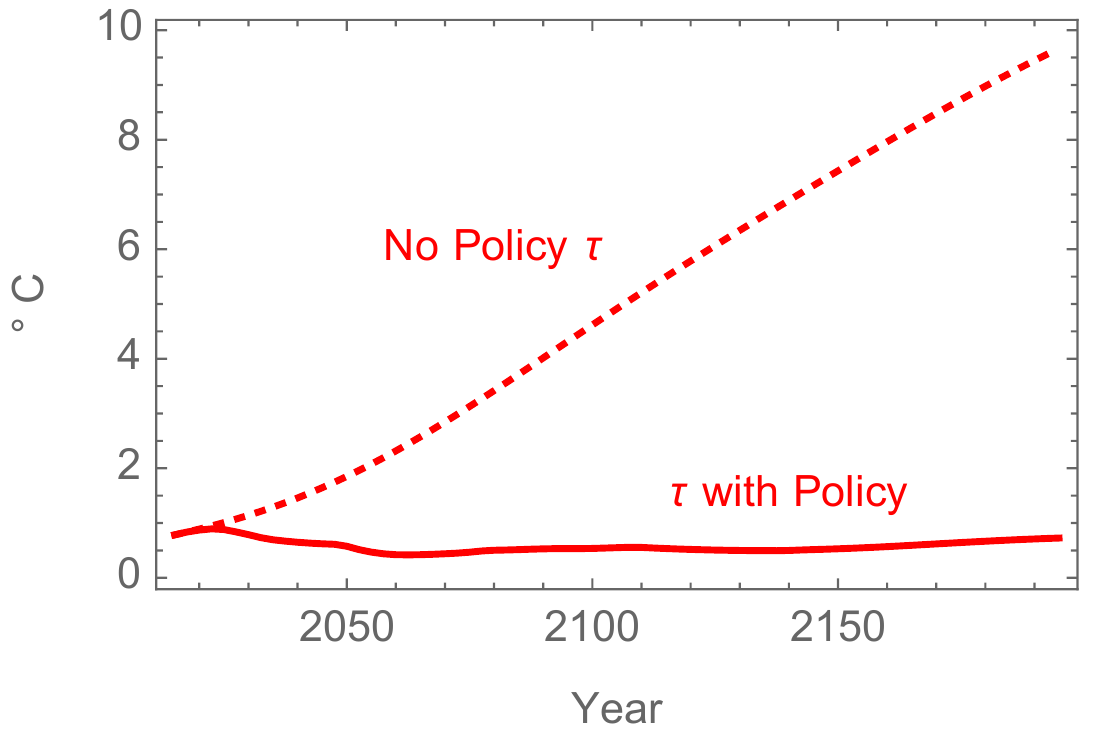
Figure 1. Industrial era global average temperature increment, τ , from 2015 to 2195 with (solid curve) and without (dashed curve) participants’ policy